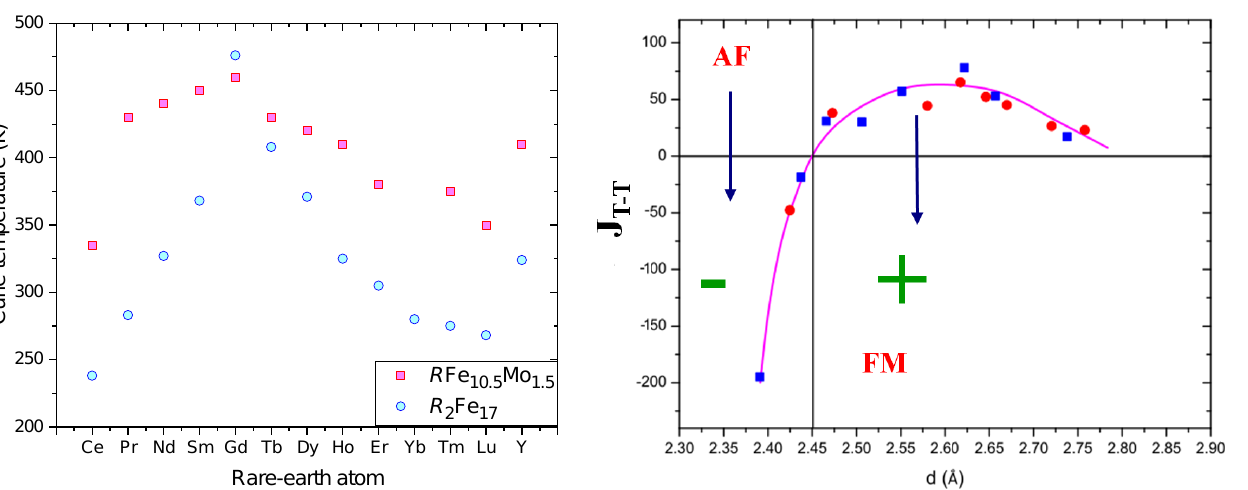
Figure 4. ( Left ) Curie temperatures for different rare-earth atoms, for R 2 Fe 17 and R Fe 10.5 Mo 1.5 [28,30,75,96–98]. ( Right ) Exchange interaction J T-T vs. distances between transition metal atoms ( T – T ) for Sm 2 T 17 . For interatomic T – T distances less than 2.45 Å the exchange interaction ( J T-T ) is negative, while J T-T is positive in the opposite case [94].